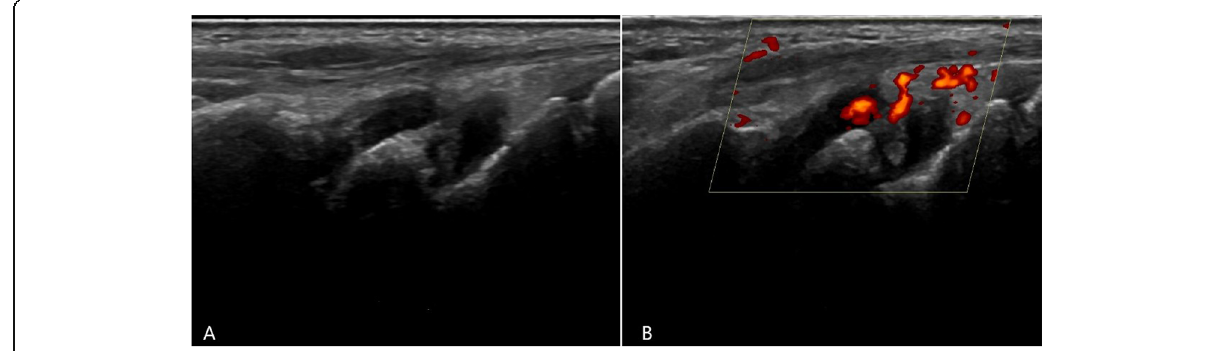
Fig. 1 Active synovitis in greyscale ( a ) and power Doppler ( b ) MSUS in 50 years old rheumatoid arthritis patient with increased albumin-dNLR score. MSUS, musculoskeletal ultrasound; dNLR, derived neutrophil-to-lymphocyte